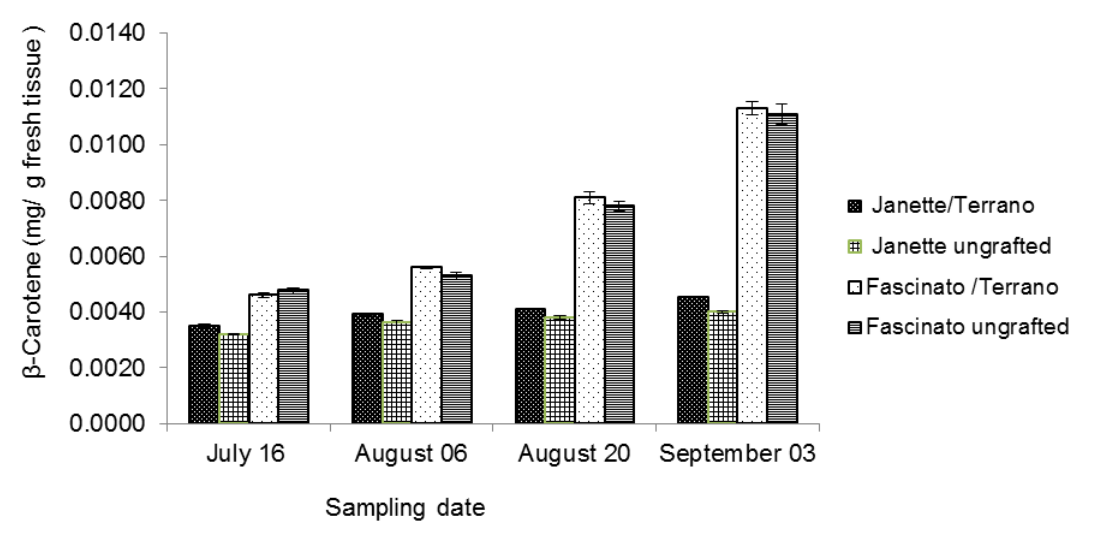
Figure 4. β -carotene concentration in two bell pepper varieties grafted and